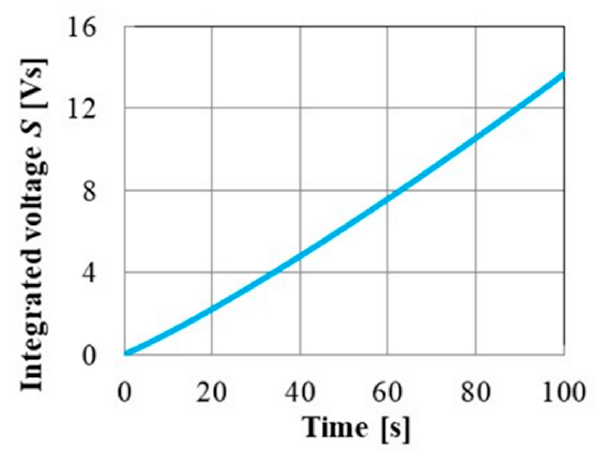
Figure 4. Integrated voltage waveform.